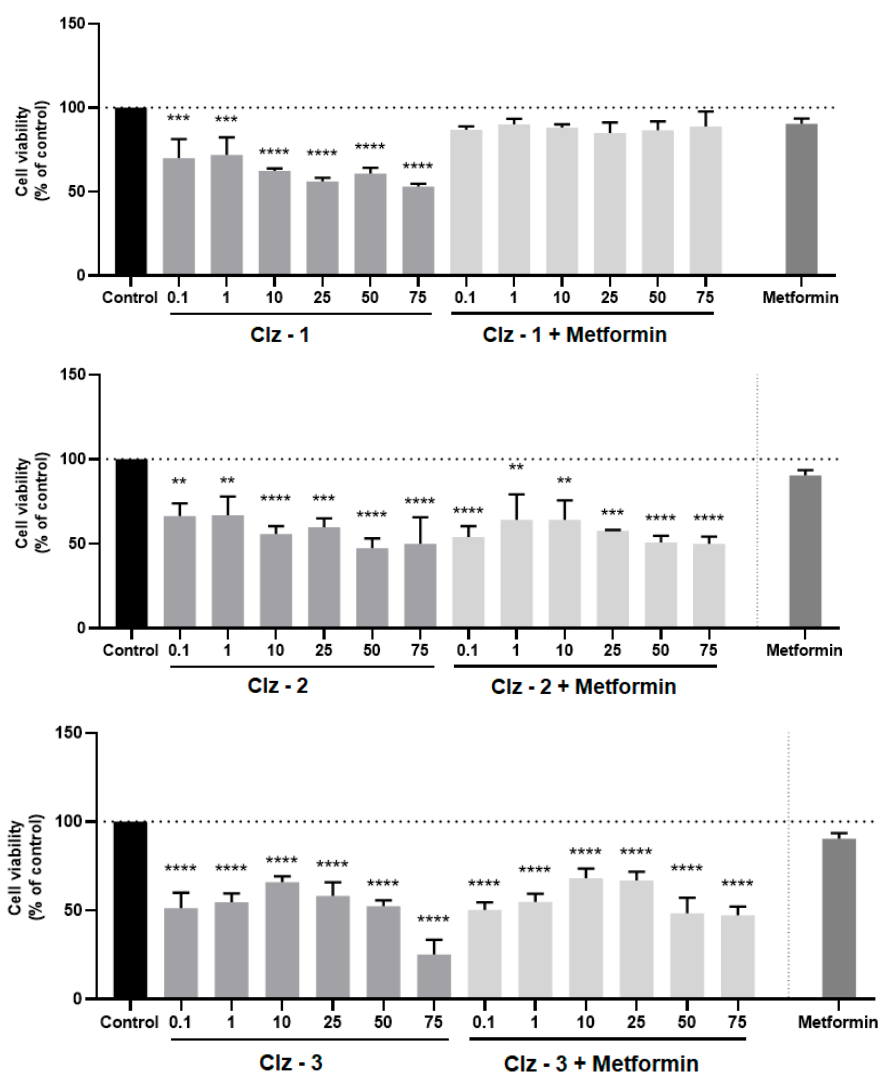
Figure 4. Relative viabilities of PC-3 cells after 24-h incubations of various concentrations of either just Clz–1, Clz–2, and Clz–3, or each Coelenterazine derivative combined with Metformin (1.27 µ M). * Significantly different from control (p <0.05).